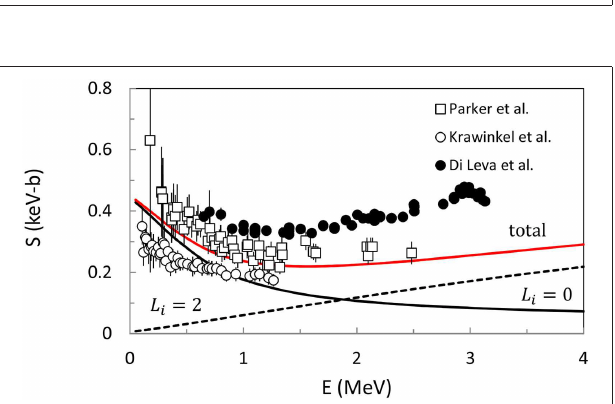
FIGURE 4 | 3 He( α , γ ) 7 Be S -factor computed in the potential model. The L i = 0 and L i = 2 components are shown separately. The data are taken from Parker and Kavanagh (1963), Kräwinkel et al. (1982), and Di Leva et al. (2009).